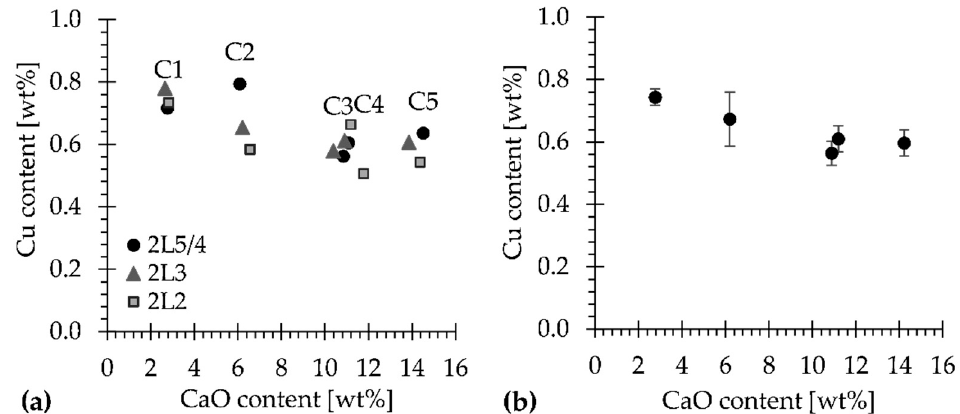
Figure 6. ( a ) Copper content versus CaO content in vertical slag samples (settling end). The samples are denoted as XLY, where X corresponds to the collection time (start of settling = 1, end of settling = 2). LY relates to the sample level (level Y = LY); ( b ) Average copper content versus average CaO content in batch C1–C5.